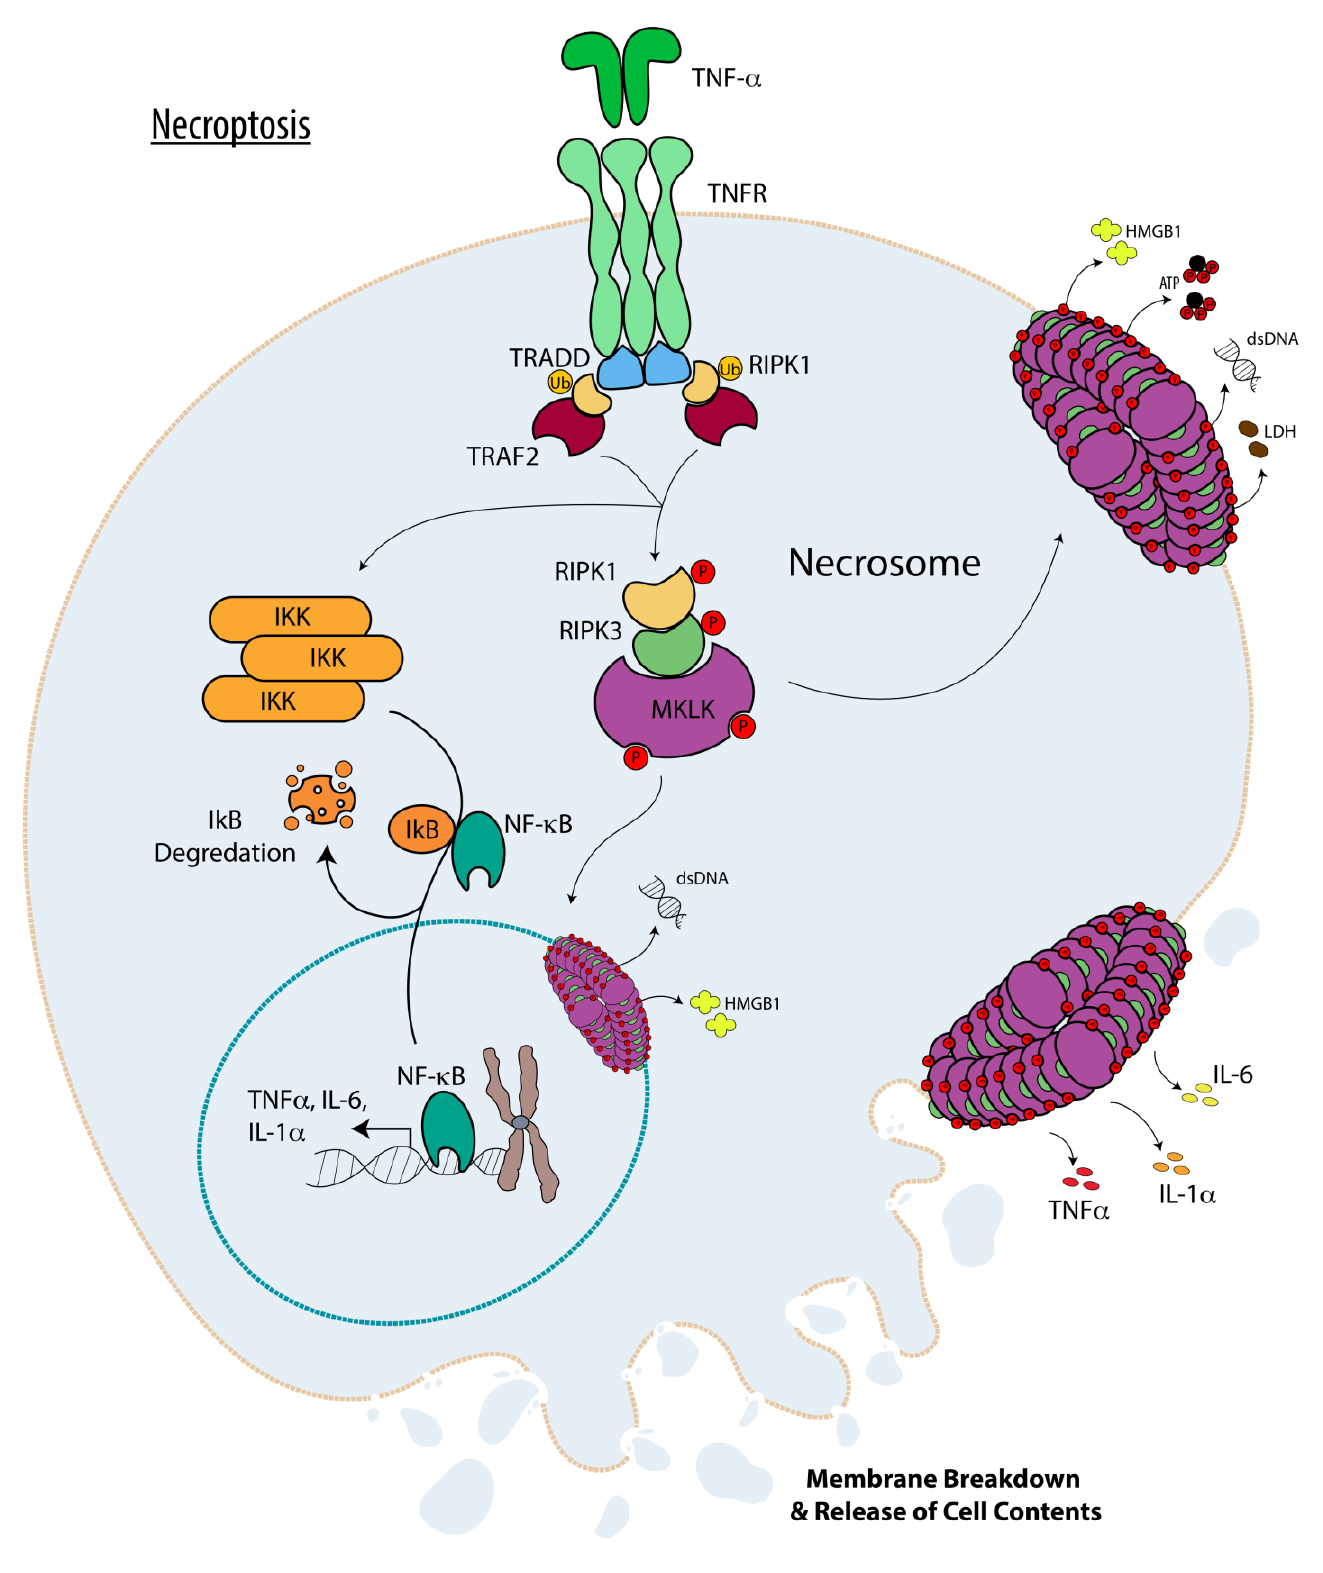
Figure 3. Necroptosis. The main players involved in necroptotic programmed cell death are depicted. The pathways are described in the text.